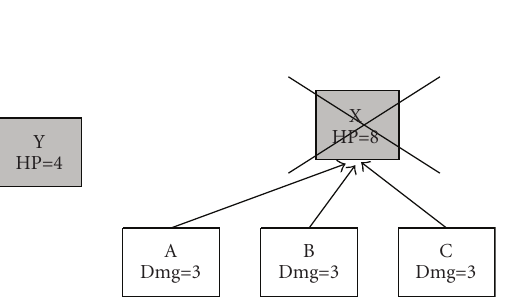
Figure 5: Attacking most damaged unit within firerange. Figure 6: Optimise attacks to destroy as many units as